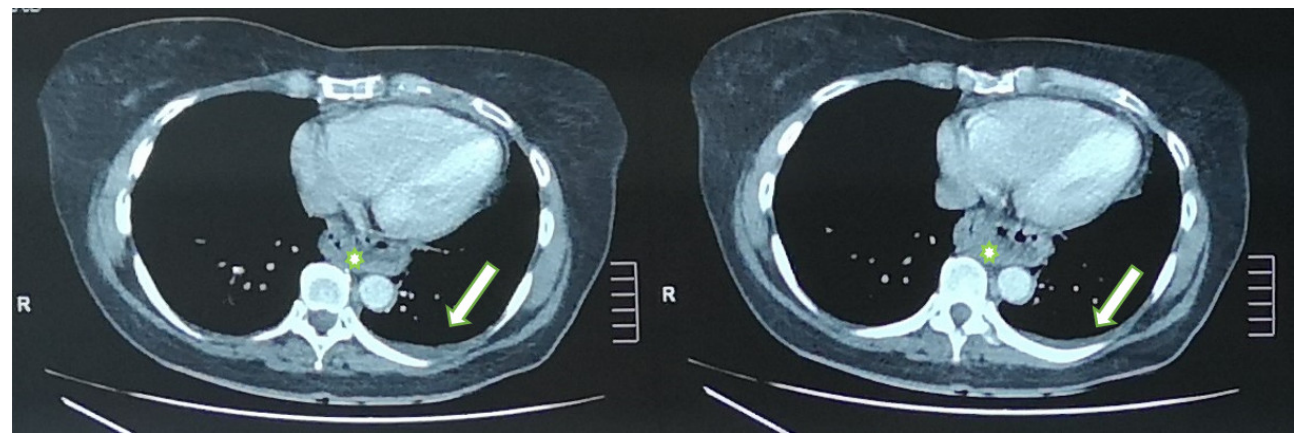
Figure 2. Axial CT images show the small left pleural effusion (arrow); diaphragmatic hernia (as- terisk).